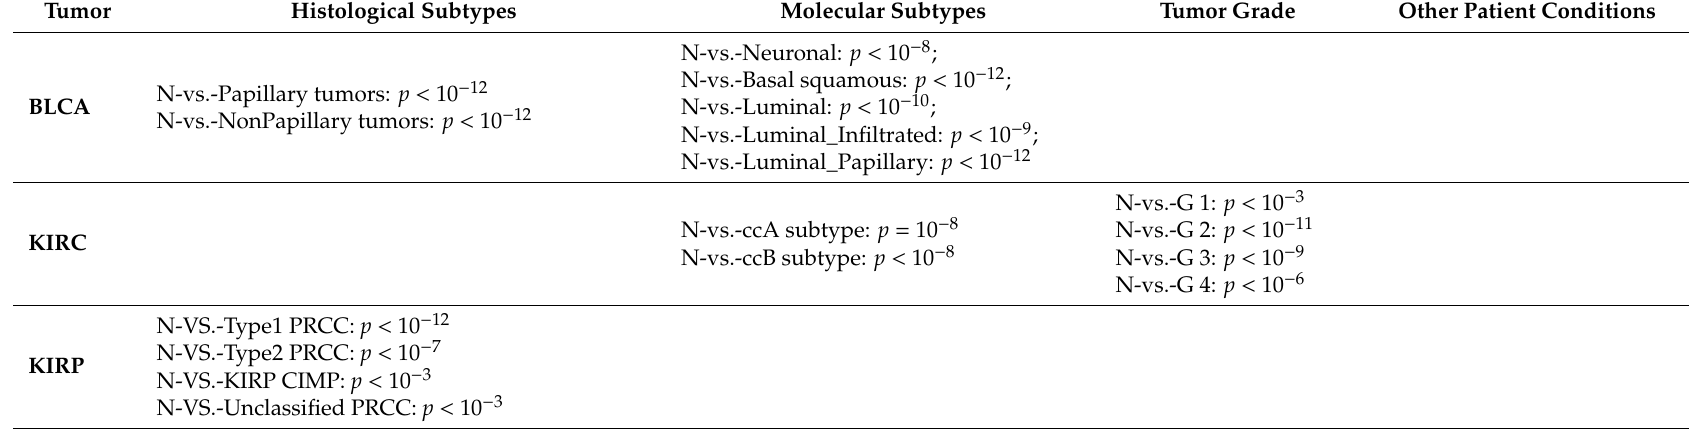
Table 1. Statistically significant UBE2C overexpression based on histological, molecular subtypes, and different patient statuses (only findings with p -value < 0.05 are given). Tumor Histological